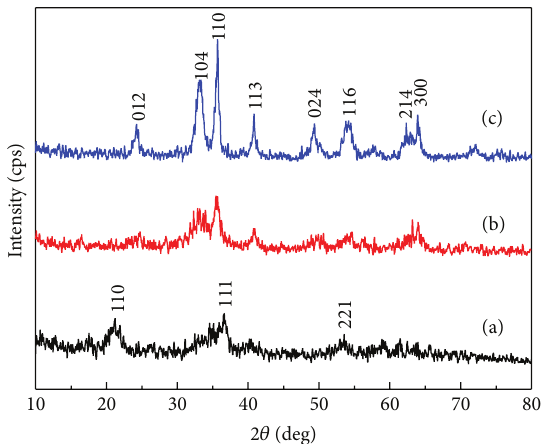
Figure 1: XRD patterns of (a) 𝛼 -FeOOH, (b) 𝛼 -Fe 2 O 3 -200, and (c) 𝛼 -Fe 2 O 3